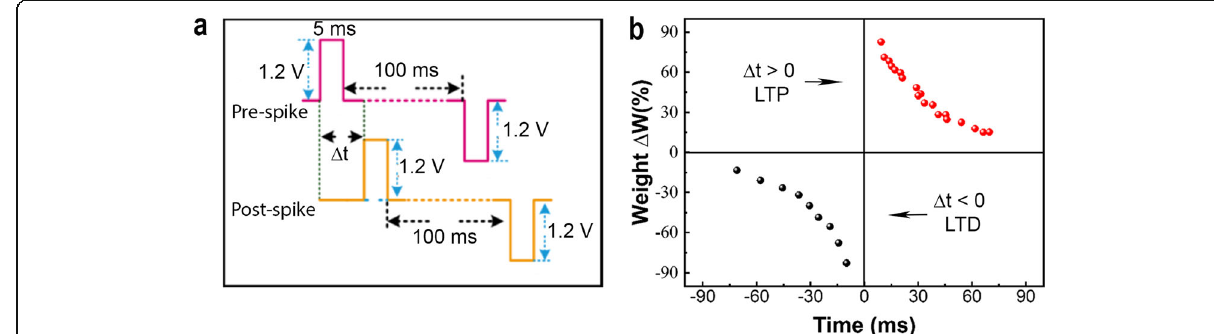
Fig. 8 Experimental results for implementation of STDP rule in Ag/SiO x :Ag/TiO x /p ++ -Si memristor device. a The schematic illustration of implementing electrical programming bias comprising the pair of pulses at amplitudes +1.2 V and − 1.2 V fixed with the same width of 5 ms. The approaching time difference between stimulus pulses is Δ t ms (t = ±10n, n = 1, 2, … , 10); b The synaptic weight ( Δ W) as a function of spike timing ( Δ t), demonstrating well on the potentiation and depression behaviors in the memristor